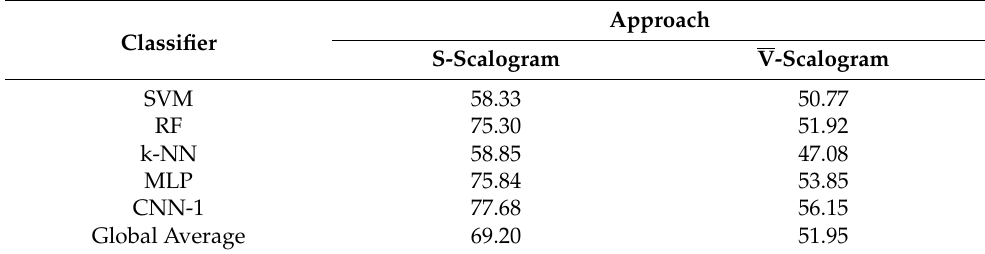
Table 3. A comparison of the average classification accuracies of the S-scalogram and the 𝑉(cid:3364) -scalo- gram approaches. Classifier